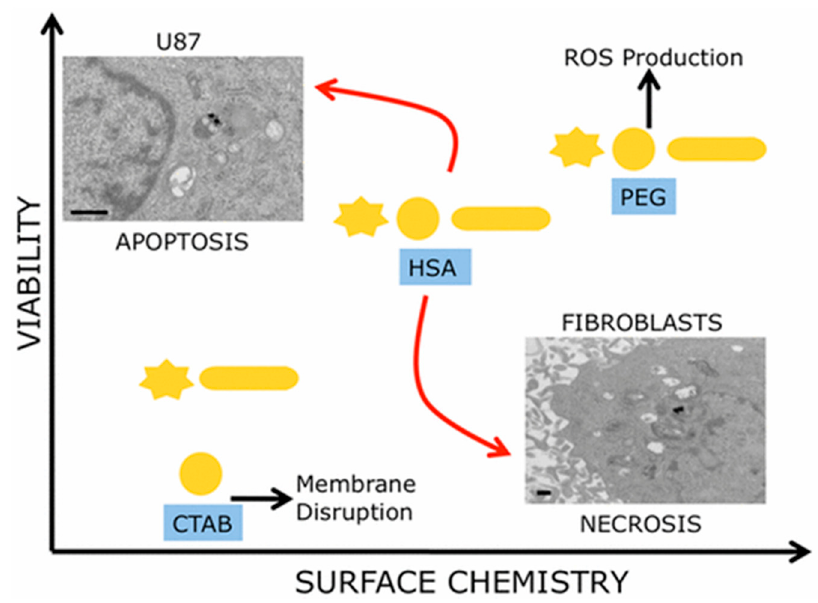
Figure 2. Surface chemistry of GNPs plays a predominant role in cell death dictation instead of size and shape. Reprinted with permission from reference [79]. Copyright (2017) American Chemical Society.